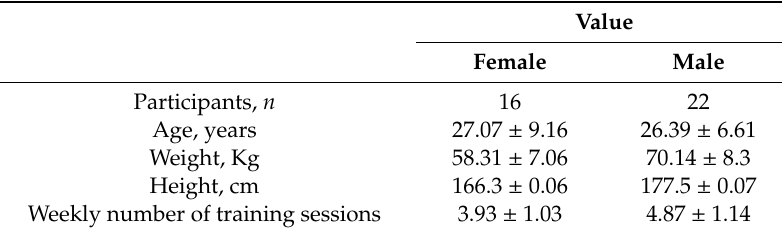
Table 1. Participant characteristics *.